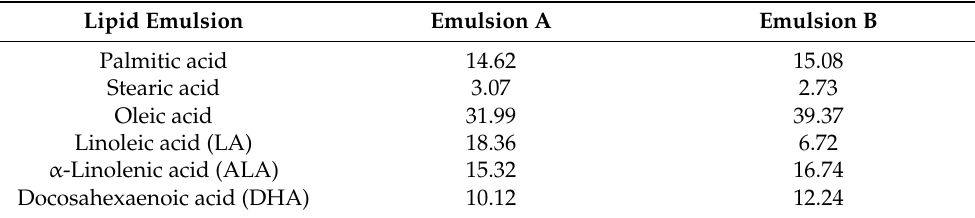
Table 1. Content of selected fatty acids in lipid emulsions. The numbers describe the content (in %) of the fatty acid in the experimental lipid emulsions A and B, respectively. Lipid